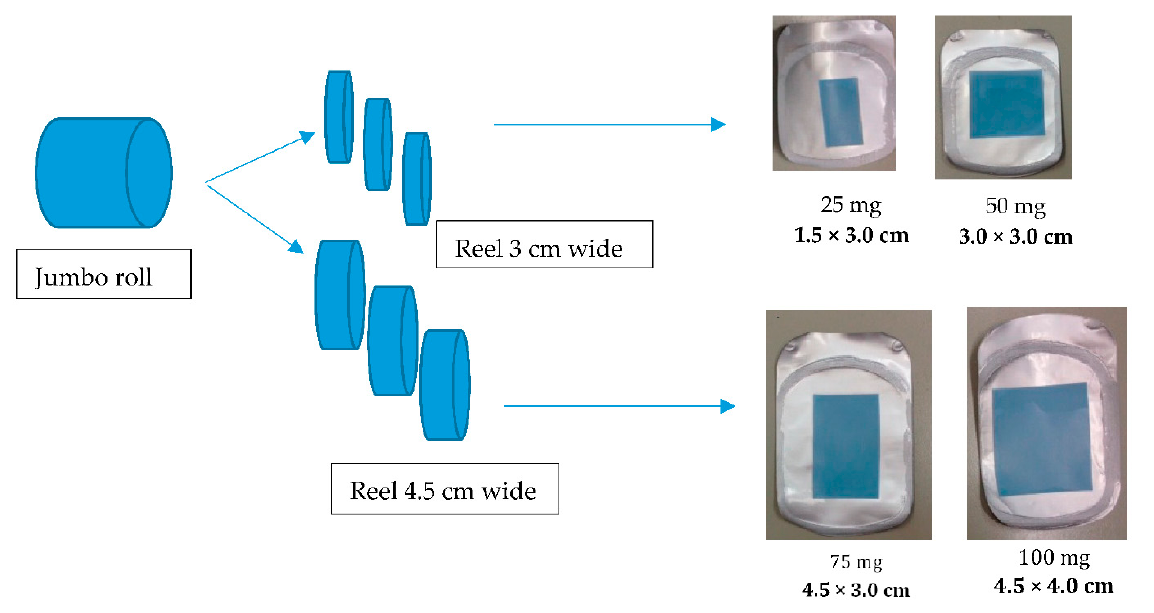
Figure 4. Manufacturing of orodispersible films of varying size. The jumbo roll is cut in reels of two different widths. Each reel is cut in films of two different dimensions.